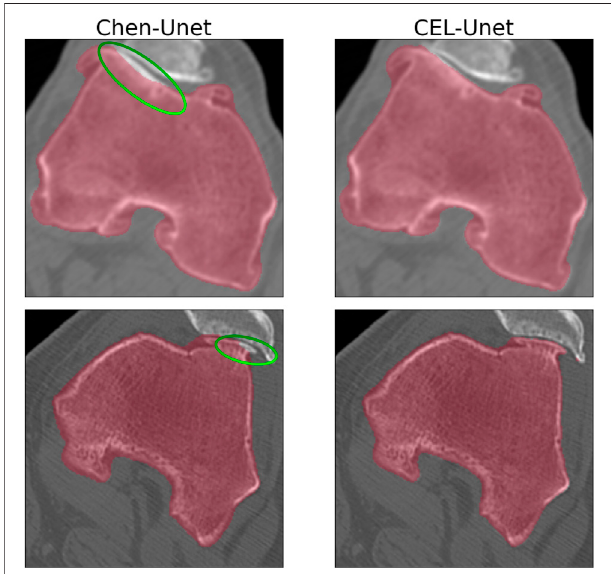
FIGURE8| Axialslicedetailaboutthesegmentationat thefemur-patella interfaceforcases#15and #181.Comparison betweenChen-Unet andCEL- Unet. Under-segmentation (Chen-Unet), highlighted by the green ellipse, at femur-patellar interface can be appreciated.